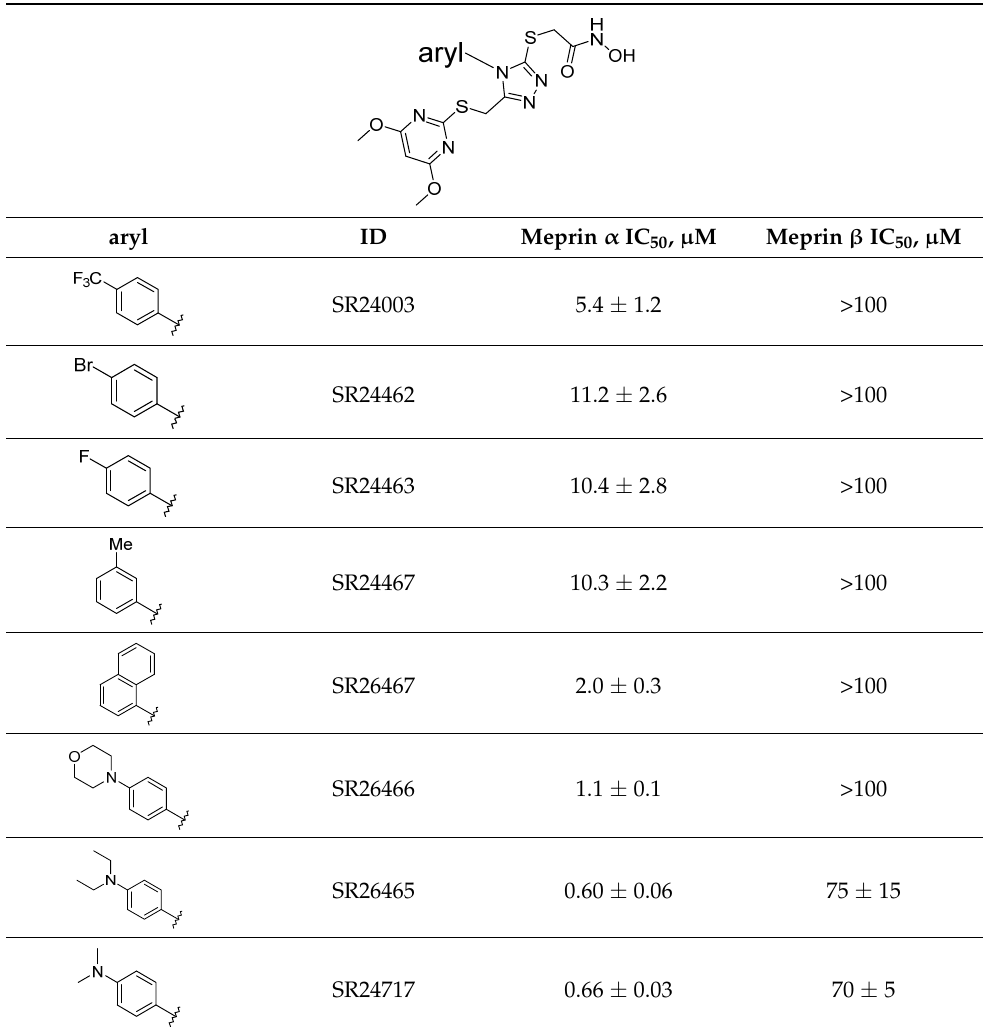
Table 2. SAR studies in the central aromatic ring. Table 2. Cont.